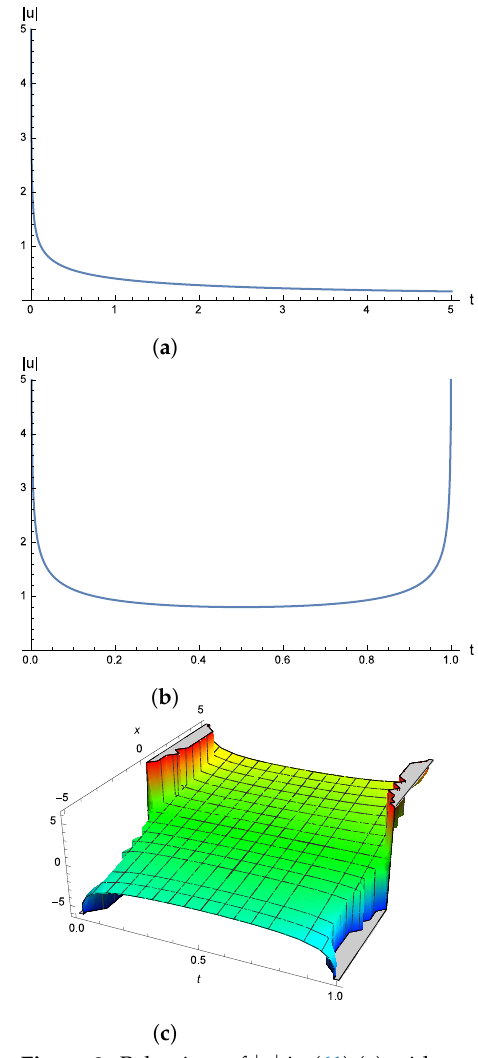
Figure 2. Behaviors of | u | in (61) ( a ) with x = 2 and c 2 = 1, ( b ) with x = 2 and c 2 = − 1, ( c ) with c 2 = −